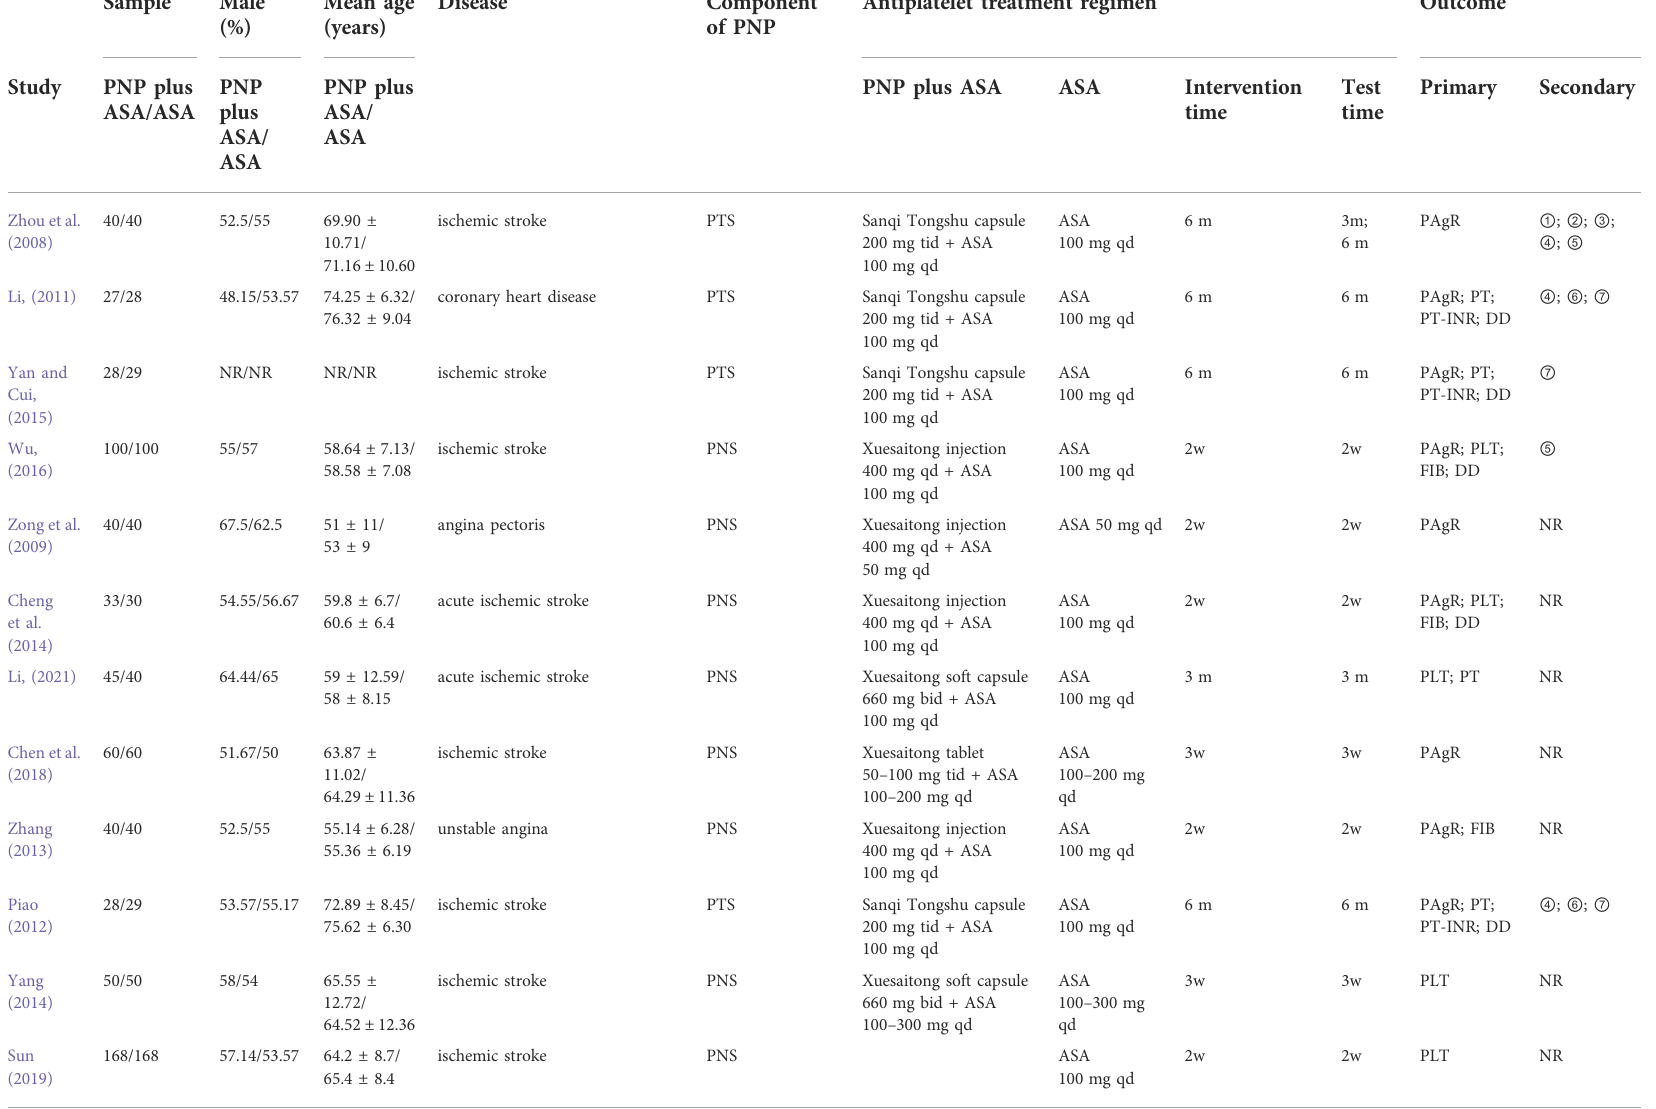
TABLE 2 Characteristic of selected